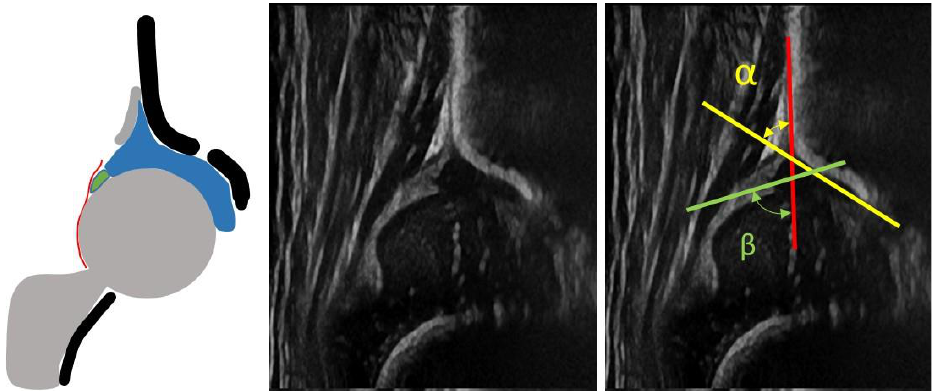
Figure 5. US image and diagram of a physiologically immature hip of a 6-week old infant. Type IIa hip according to Graf.